Question: In a single sentence, describe what this figure presents.
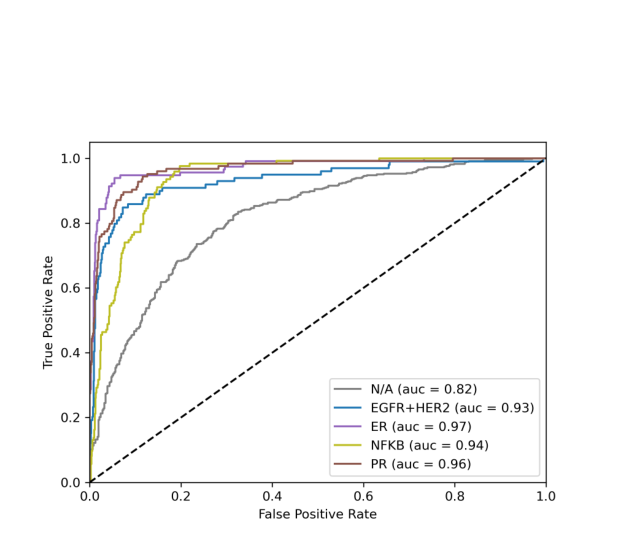
Answer: The ROC plots for different classes with one-vs-rest strategy.